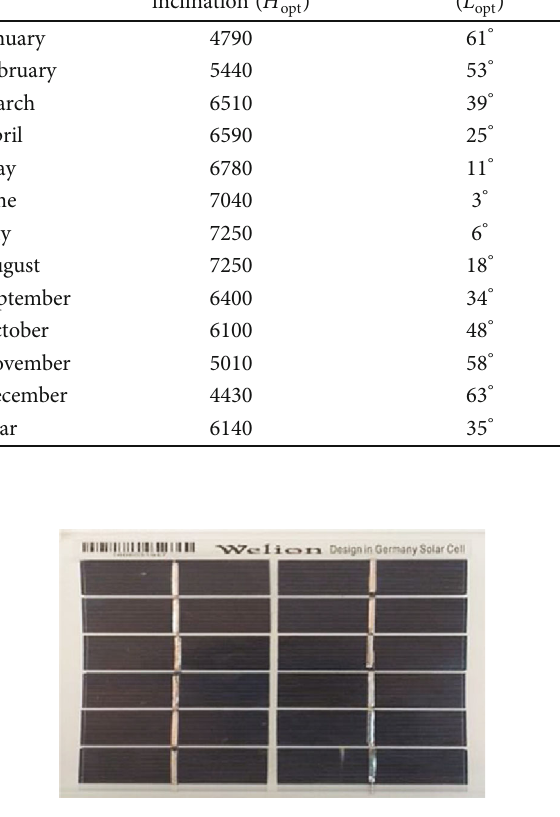
Figure 5: Photovoltaic